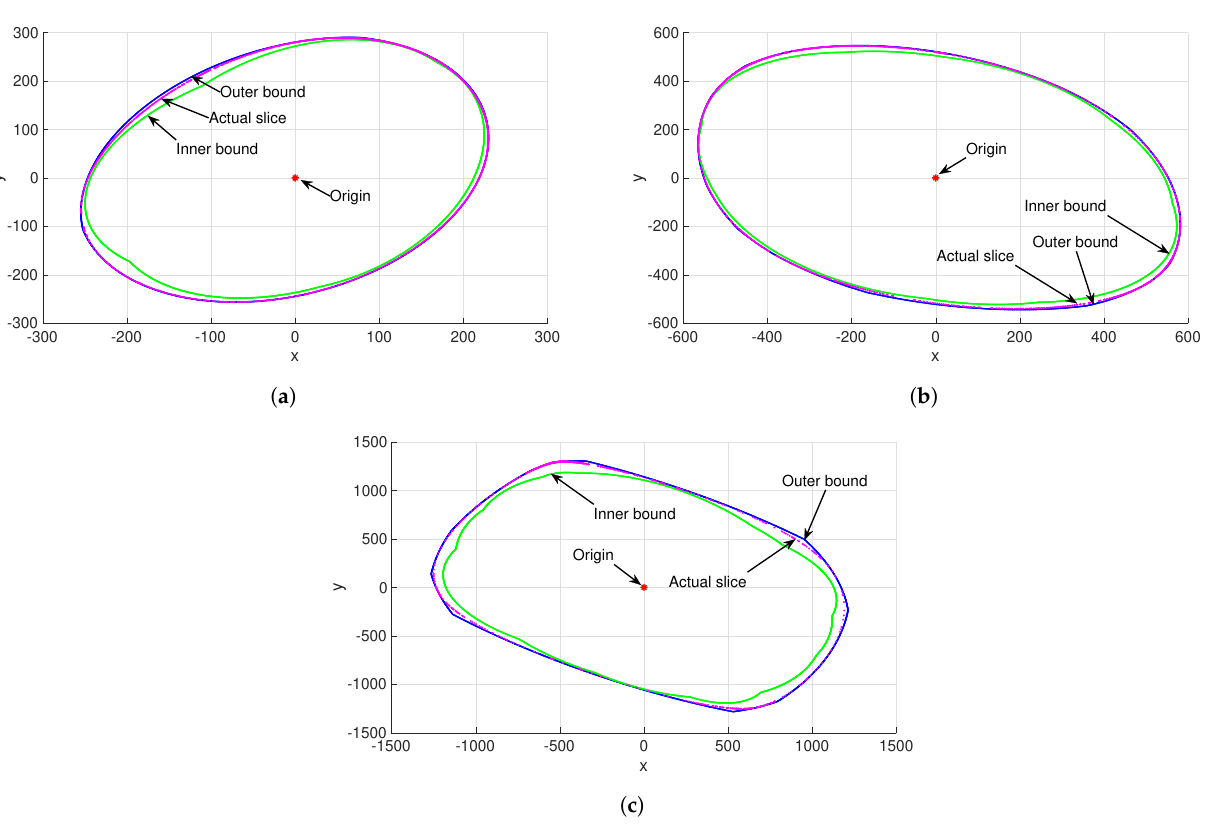
Figure 8. Strips for a similar actual slice of Minkowski sum (pink) with Figure 7, generated by ( a ): MVOE, four outer Kurzhanski’s, John’s inner and four inner Kurzhanski’s, ( b ): MVOE and eight outer Kurzhanski’s, ( c ): MVOE and ten outer Kurzhanski’s. Figure 9a–c successively show the strips generated by MVOE, four outer Kurzhanski’s, John’s inner and four inner Kurzhansk’s for similar slicing samples in Figures 4e,f, 5 and 6, for which the suggested parametric model presented weak approximations of the ac- tual slice.